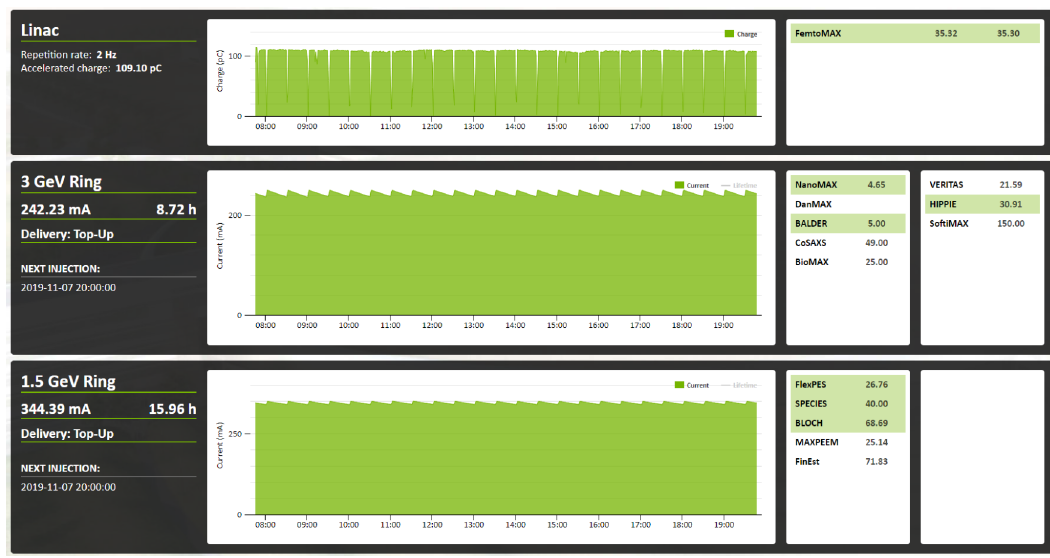
Figure 2. MAX IV status page on 7 November